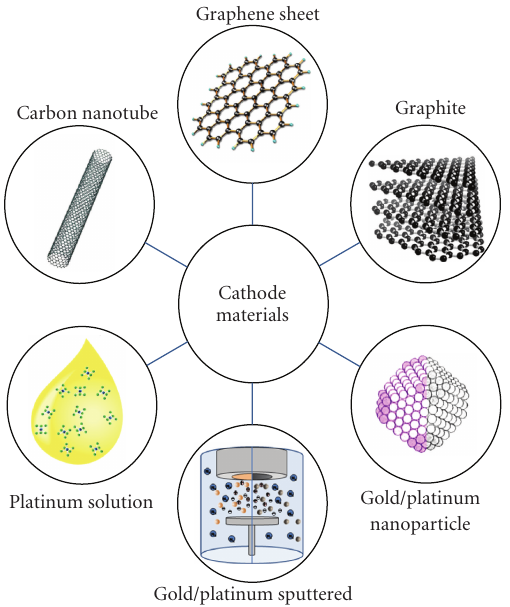
Figure 2: Schematic representation of the materials which can be used in DSSC as catalyst.